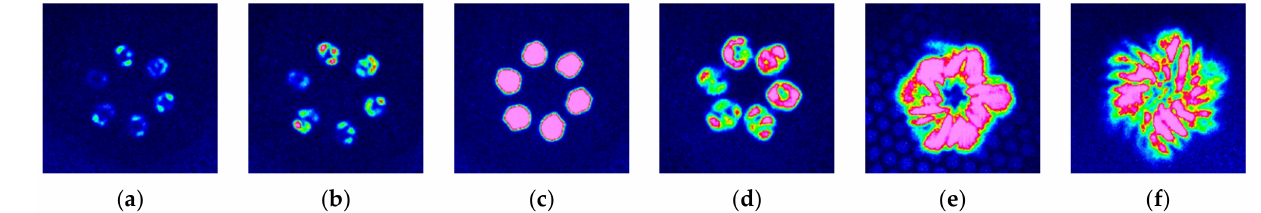
Figure 16. Far-field laser beam profiles, measured at the receiving end after propagation over 5 m long 100 rpm twisted graded-index six-core-MOF, connected to BLD source ( λ = 1550 nm) via SMF with an air gap of 150 . . . 200 µ m to provide OFL conditions under various laser-excited emission intensities and distances between the MOF receiving end and the IR-camera objective: ( a ) low intensity, 0 µ m; ( b ) medium intensity, 0 µ m; ( c ) maximal intensity, 0 µ m; ( d ) medium intensity, 20 µ m; ( e ) medium intensity, 40 µ m; ( f ) medium intensity, 70 µ m.